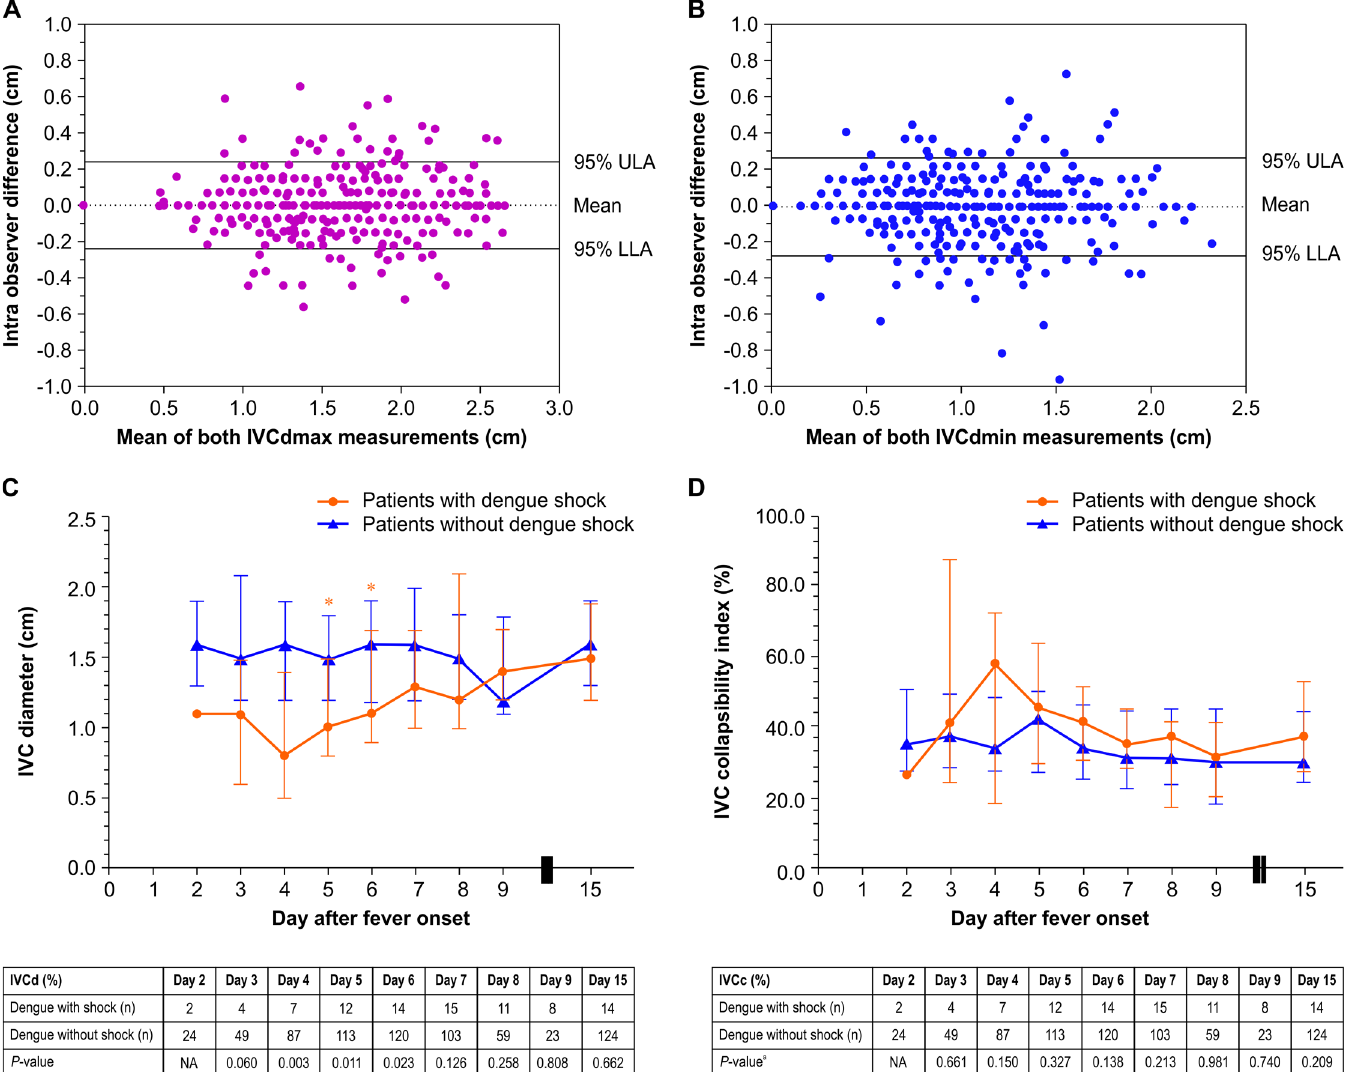
Fig 4. Inferior vena cava parameters by day after fever onset among patients with and without dengue shock. (A) A Bland-Altman plot of data from the intraobserver reliability study. The mean IVCdmax (cm) of each patient was plotted against the difference in IVCd (cm) between two measurements (811 measurements each) obtained by the same observer. (B) A Bland-Altman plot of data from the intraobserver reliability study. The mean IVCdmin (cm) of each patient was plotted against the difference in IVCd (cm) between two measurements (811 measurements each) obtained by the same observer. (C) IVCd (cm) after fever onset among patients with and without dengue shock (D) IVCc (%) after fever onset among patients with and without dengue shock. IVCc = Inferior vena cava collapsibility index; IVCd = inferior vena cava diameter; IVCdmax = maximum inferior vena cava diameter; IVCdmin = minimum inferior vena cava diameter; LLA = lower limit of agreement; NA = not applicable; ULA = upper limit of